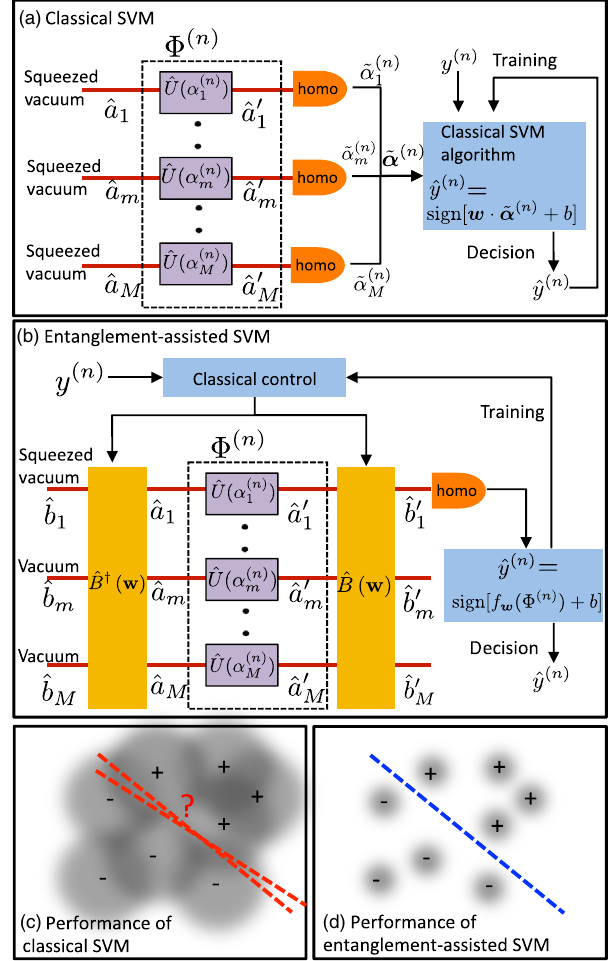
FIG. 3. Schematic of the classification task of an unknown quantum channel Φ ð n Þ comprised of M displacement operations parametrized by an unknown vector α ð n Þ ¼ f α ð n Þ 1 ; … ; α ð n Þ “ homo ” denotes a homodyne measurement. (a) Schematic of a classical SVM with separable probe states, which obtain a full noisy classical description ˜ α ð n Þ about the probed object and then feed it into a classical SVM algorithm. (b) Schematic of the entanglement-assisted SVM. Two variational circuits ˆ B ð w Þ are trained to generate the optimum entangled probe state and to preprocess the quantum state forthe optimummeasurement. The classical control algorithm uses the simultaneous perturbation stochastic approximation (SPSA) method to update the setting w for the variational circuits. (c,d) Illustration of the performance contrast between the entanglement-assisted SVM and classical SVM in the parameter space. The labels “ þ ” and “ − ” denote the different classes of the channels. The blur is due to measurement uncertainties. While the measurement uncertainty renders classical SVM inaccurate, the entanglement-assisted SVM remains